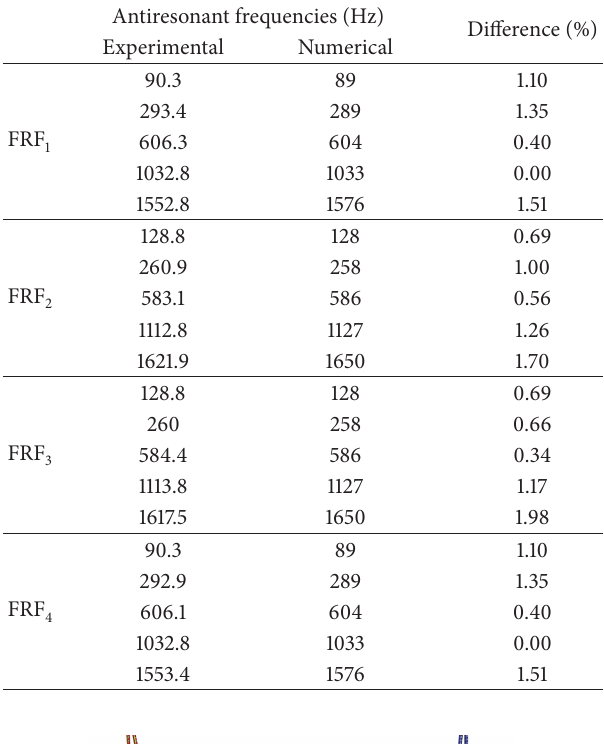
Table 5: Experimental and numerical antiresonances.